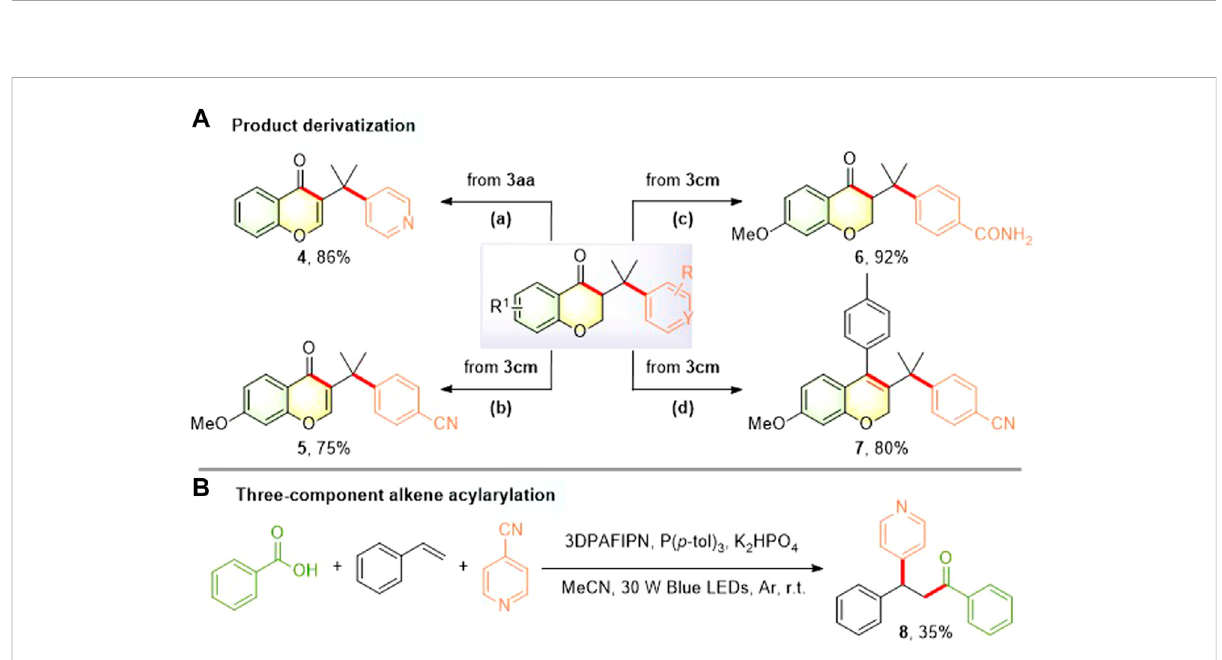
FIGURE 4 Productderivatization (A) andthree-componentalkeneacylarylation (B) .Reactionconditions:(a)I 2 ,DMSO,re fl ux2 h(b)I 2 ,DMSO,re fl ux2 h(c) 30%